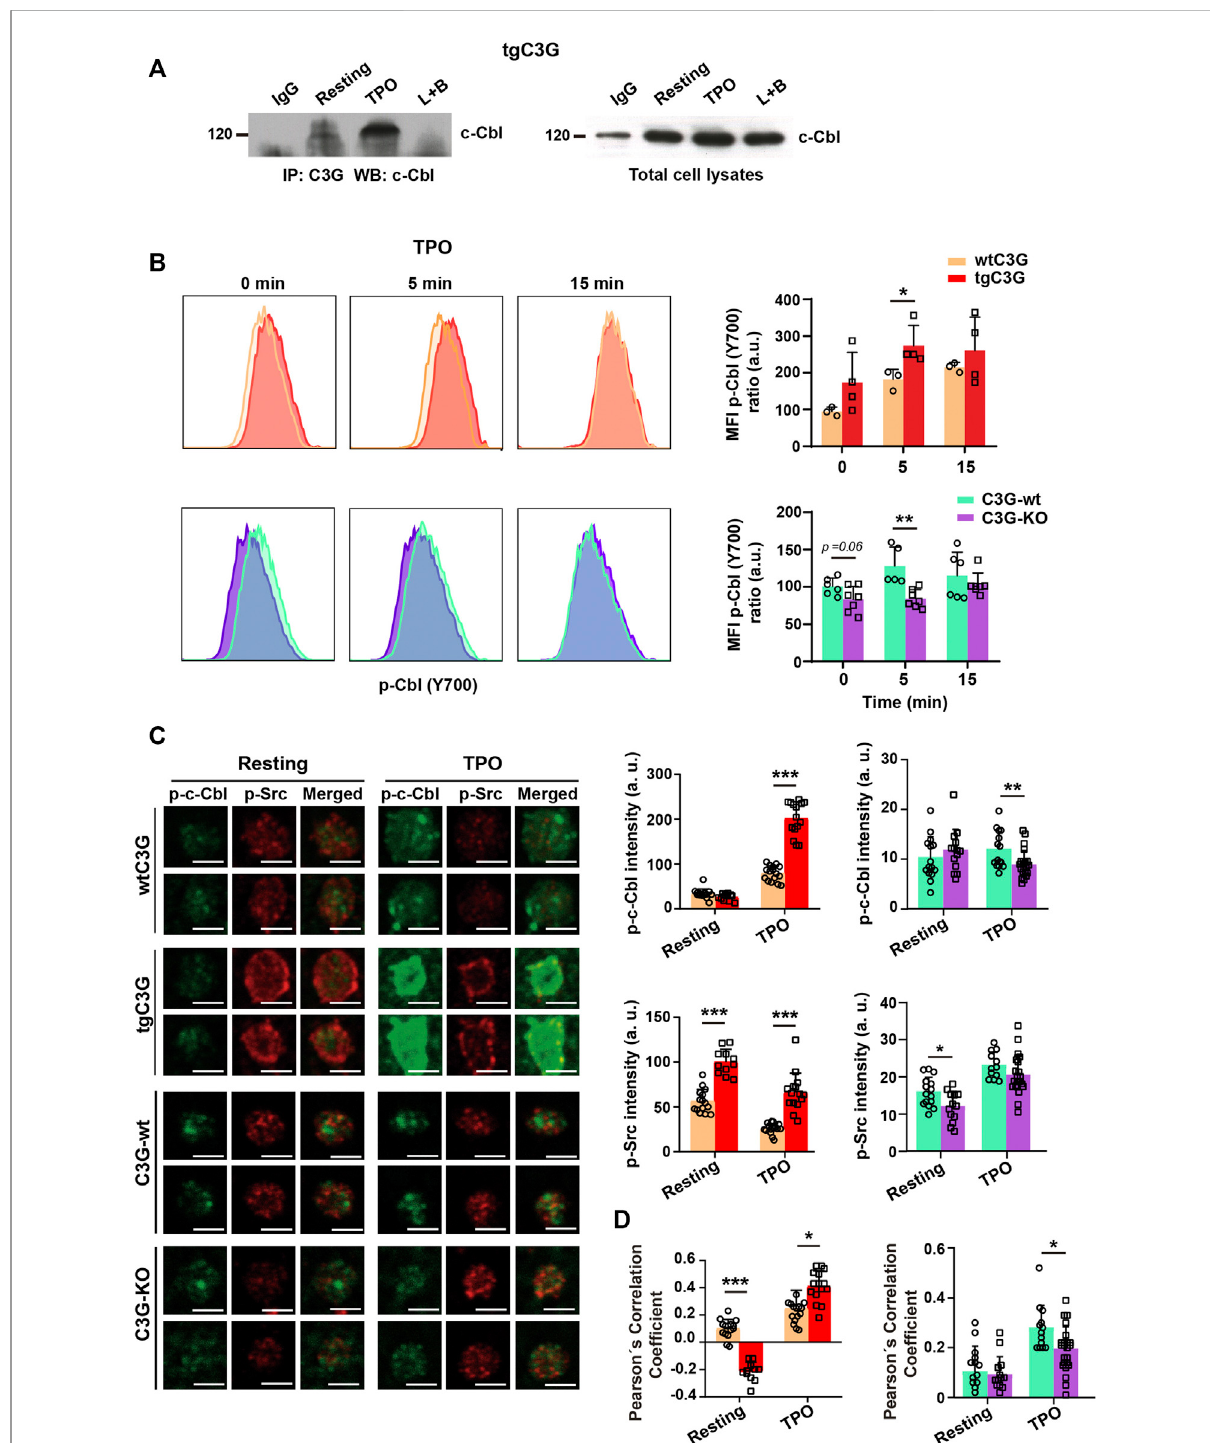
FIGURE 6 C3Ginteractswithc-Cblandpromotesc-Cbl phosphorylationbySrc. (A) LysatesfromtgC3Gplatelets,untreatedortreatedwithTPO(100 ng/ml, 5 min were immunoprecipitated with anti-C3G antibodies and the levels of c-Cbl determined by western blot. IP: immunoprecipitation, WB: western blot.IgGandlysate+agarosebeads(L+B)wereusedasnegativecontrols. (B) tgC3GandC3G-KOplatelets,andtheircontrolswerestimulatedwithTPO fortheindicatedtimepoints.Intracellularphospho-c-Cbllevelsweredeterminedin fi xedcellsby fl owcytometry,asdescribed(Marklinetal.,2020). Left:representative fl owcytometryplots.Right:Histogramsrepresentthemean±SDoftheMFIvalue,calculatedrelativetothemeanvalueofuntreated